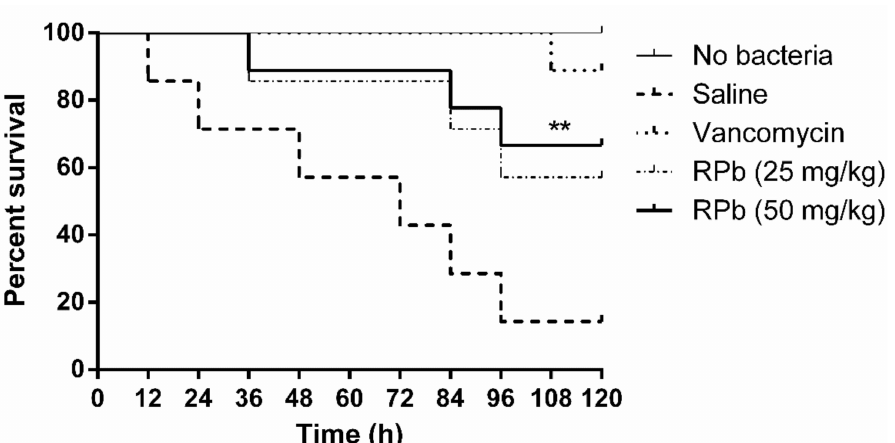
Figure 9. The percentage survival waxworms infected with MRSA. The infected waxworms were treated with vancomycin (20 mg / kg) and RPb (25 mg / kg and 50 mg / kg), respectively. ** p < 0.01 and * p < 0.05 indicate significant di ff